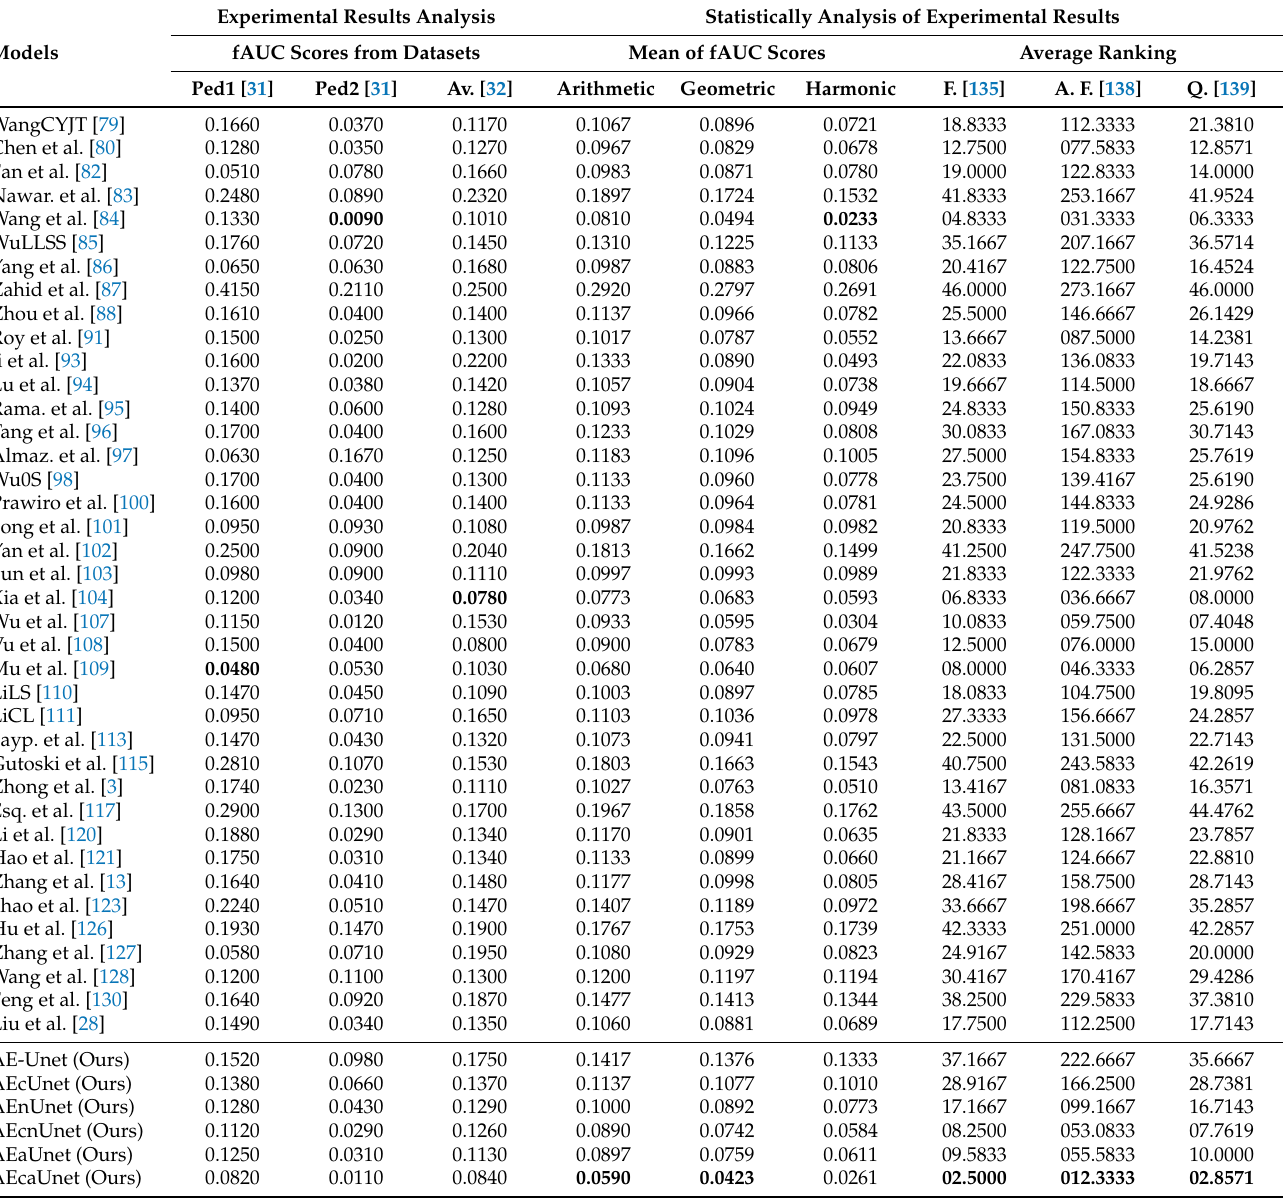
Table 8. Multiple comparison test for G 3 using fAUC. Column-wise the best numerical result is shown in bold